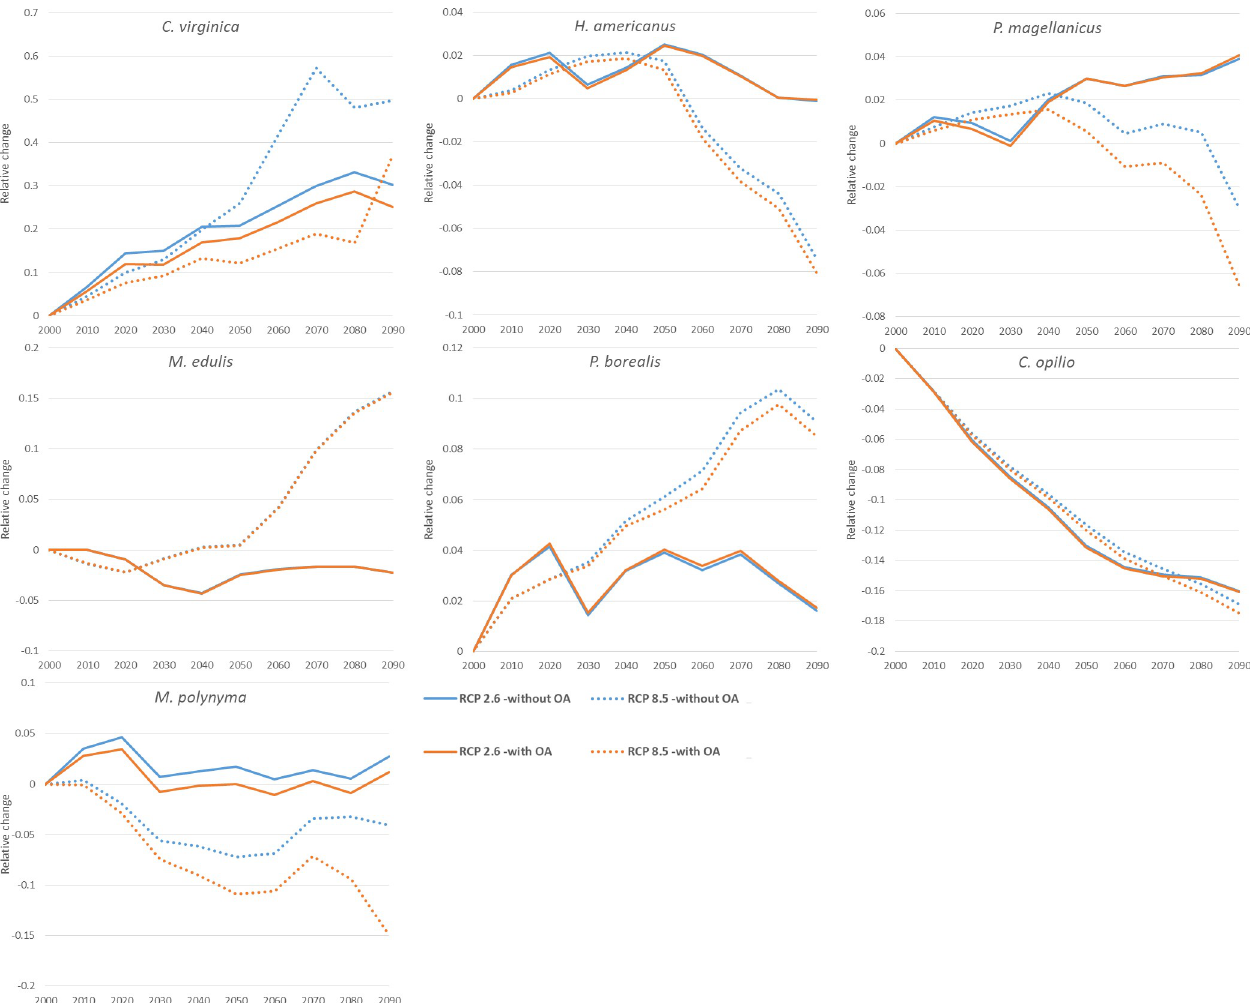
Fig 6. Comparison of model outputs with OA (red) and without OA (blue) effects through the century, under both climate scenarios (RCP 2.6 as solid lines, RCP 8.5 as dotted lines) for whole Atlantic Canadian EEZ. Values are relative changes in catch potential. Note different axes between sub-plots. (S1 Fig. contains relative changes in distribution for both ‘with OA’ and ‘without OA’ treatments). Lines represent multi-model medians from outputs of three earth system models (GFDL, IPSL,